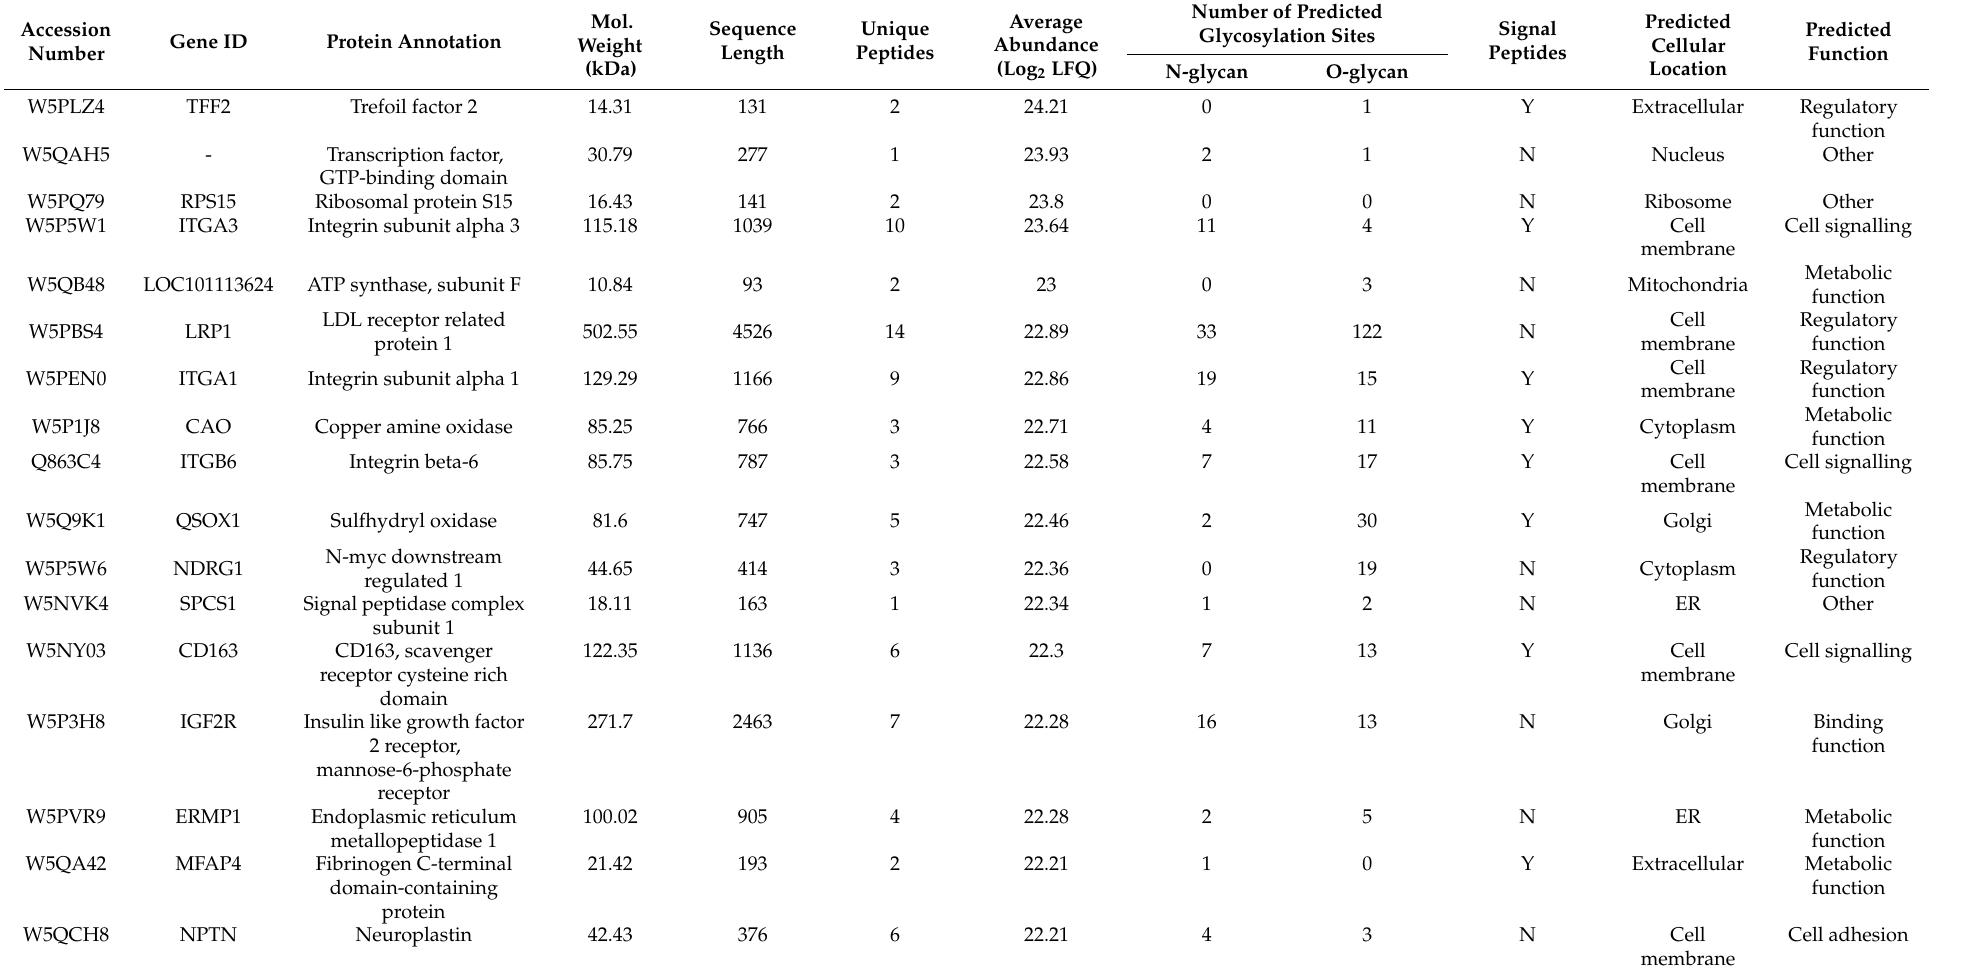
Table 2. Identification by mass spectroscopy of top 50 most abundant sheep abomasal scrape tissue (ST) proteins eluted from a Tci-gal-1